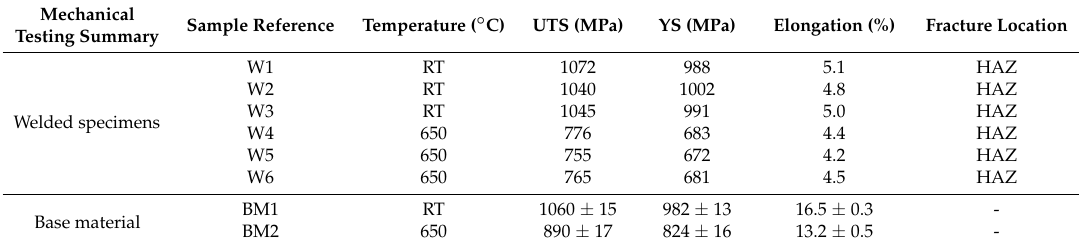
Table 3. Summary of the mechanical testing performed on the welded specimens and base material at room temperature (RT) and 650 °C. For the base material the average results presented are based on a total of three samples tested at both temperatures.